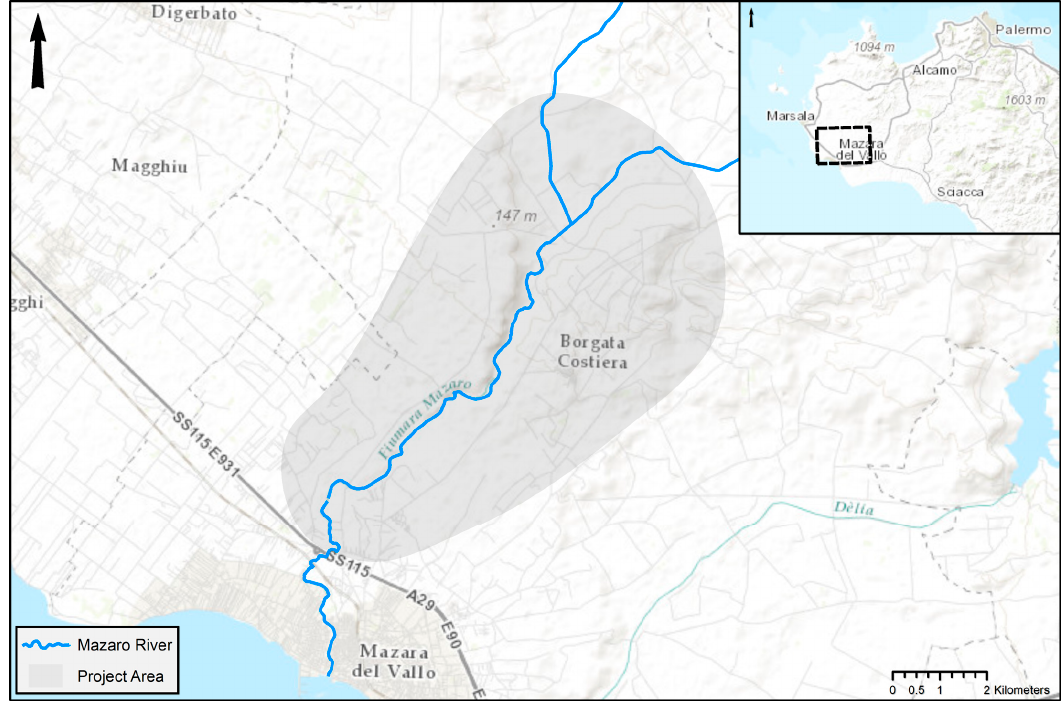
Figure 5. The Prospecting Boundaries project area, western Sicily. Background image © ESRI.